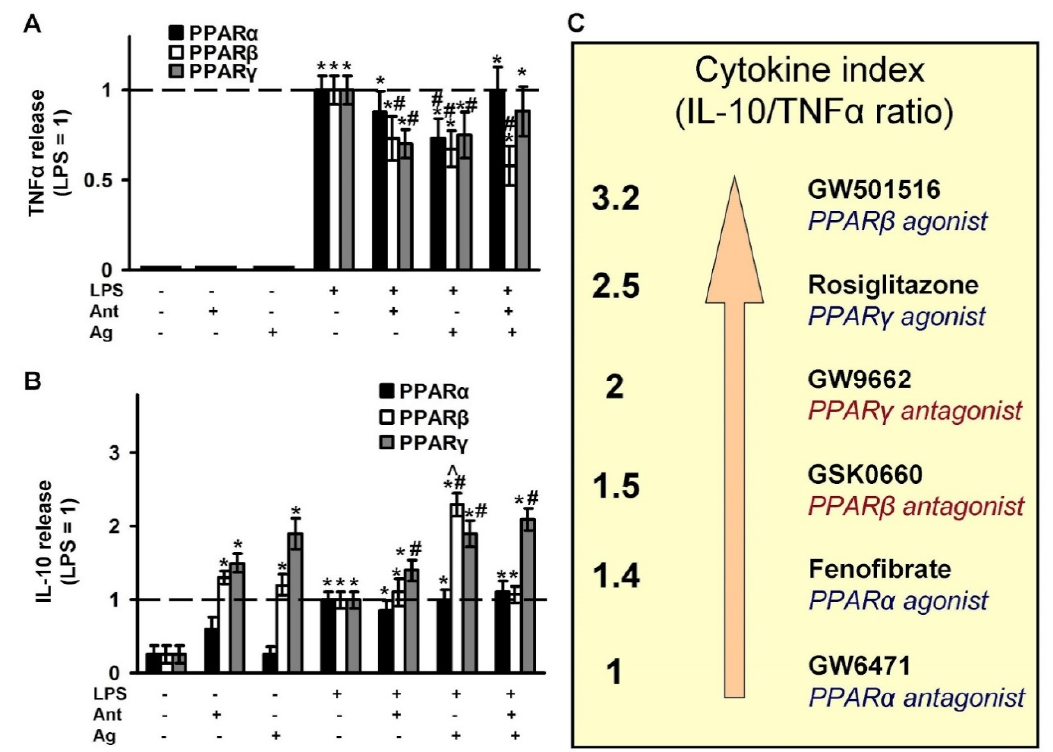
Figure 6. E ff ect of PPARs ligands on the inflammatory response. The primary rat astrocyte cultures were pretreated with PPAR α agonist Fenofibrate (50 µ M), PPAR α antagonist GW 6471 (5 µ M), PPAR β agonist GW501516 (25 µ M), PPAR β antagonist: GSK0660 (5 µ M), PPAR γ agonist Rosiglitazone (20 µ M), PPAR γ antagonist GW9662 (5 µ M) for 30 min and then stimulated with LPS (100 ng / mL) for 4 h. The TNF α ( A ) and IL-10 ( B ) protein release measured by ELISA in supernatant samples. The results are expressed as fold-changes, relative to LPS-stimulated cells. The values represent a mean ± SEM from three independent experiments. * p < 0.05, compared with the non-stimulated cells, # p < 0.05, compared with the LPS-stimulated cells, ˆ p < 0.05 compared with the agonist-treated cells. ( C ) Cytokine index as a ratio IL-10 and TNF α allows to line up a row for the tested substances relative to their anti-inflammatory and resolution features.